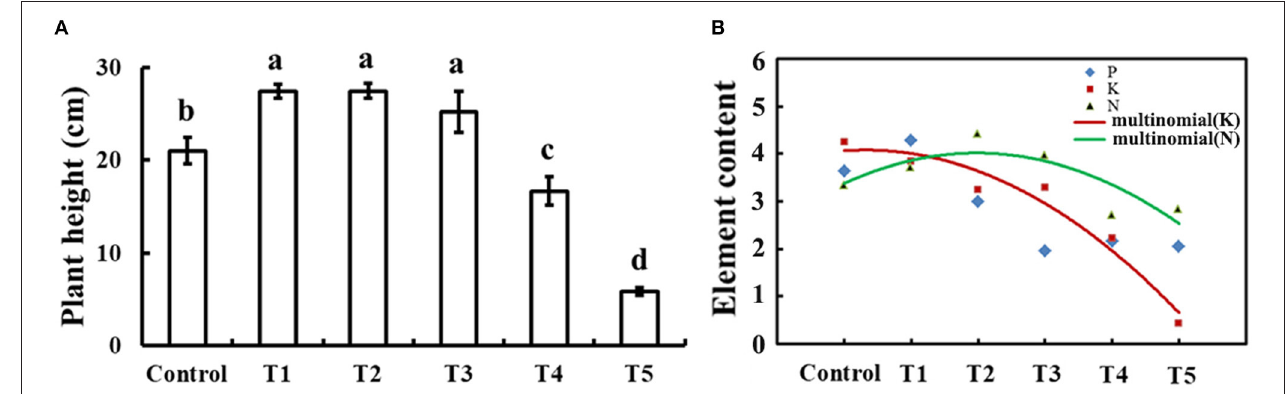
FIGURE 1 | Plant height and element contents in response to exogenous selenium with different concentrations. (A) Plant height of cucumber seedlings treated with 0, 1, 10, 50, 100, and 1,000 µ M exogenous selenium for 10 days. These values are expressed as means of three replicates ± SD, and different letters are significantly different ( P < 0.05). (B) Element (N, P, and K) content with 0, 1, 10, 50, 100, and 1,000 µ M exogenous selenium for 10 days in cucumber seedlings root. These values are expressed as means of three